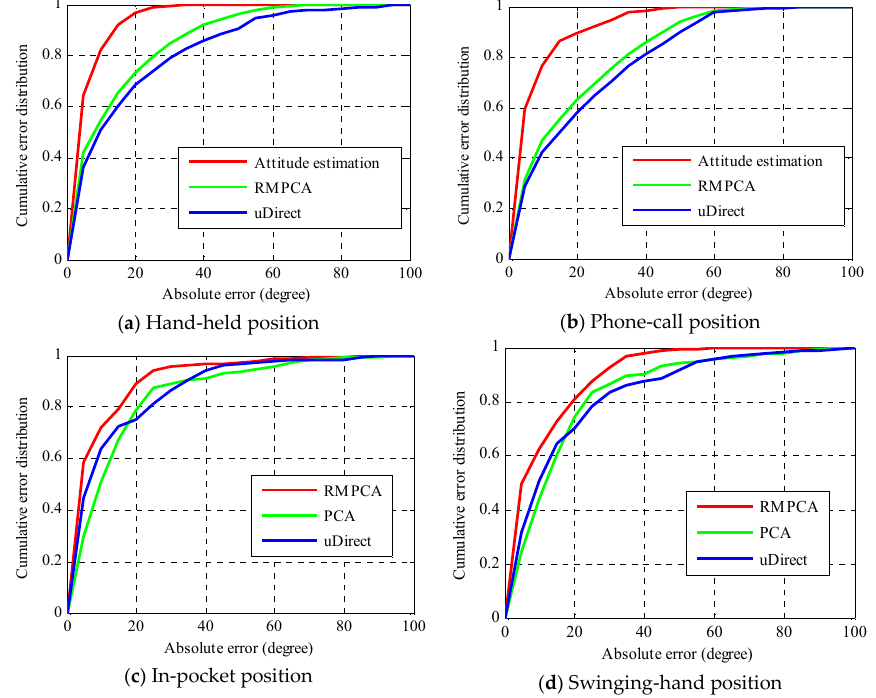
Figure 8. Absolute heading estimation error distributions comparisons of different approaches with four fixed carrying positions in the first scenario of Environment 1. Table 3. Mean and standard deviation of absolute estimation error (degree) in the first scenario for Environment 1 (E1) and Environment 2 (E2).